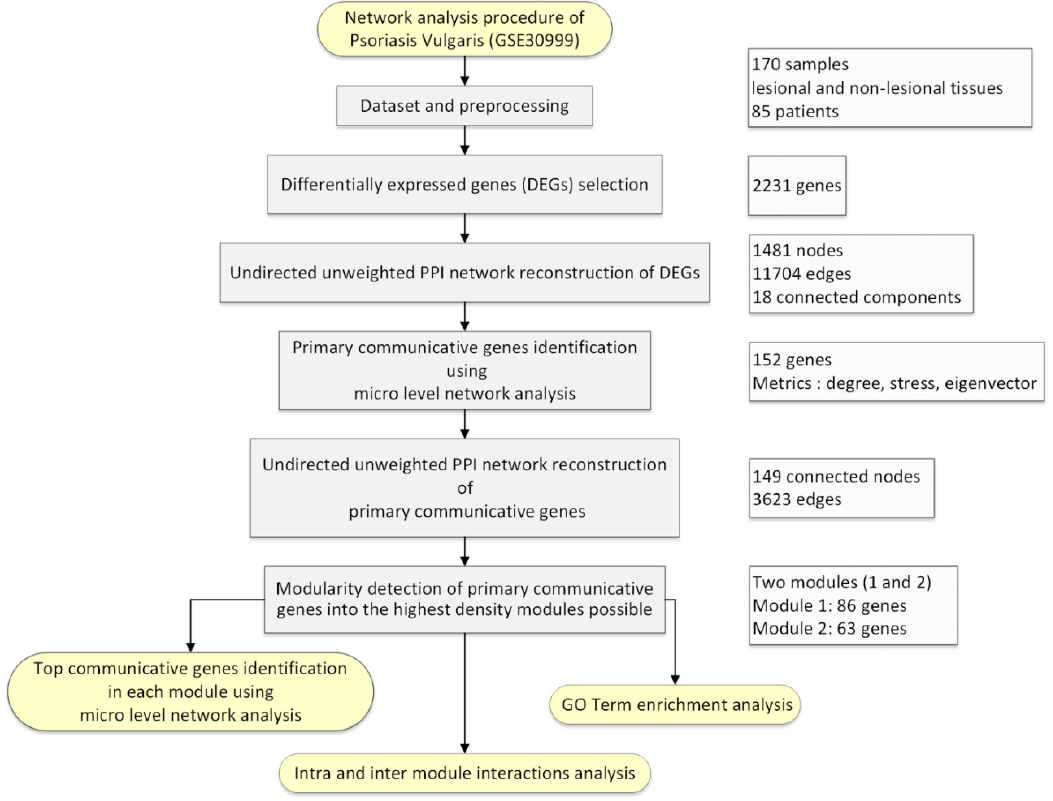
Figure 1. Workflow of the study design of the network analysis of psoriasis vulgaris patients dataset (GSE30999).